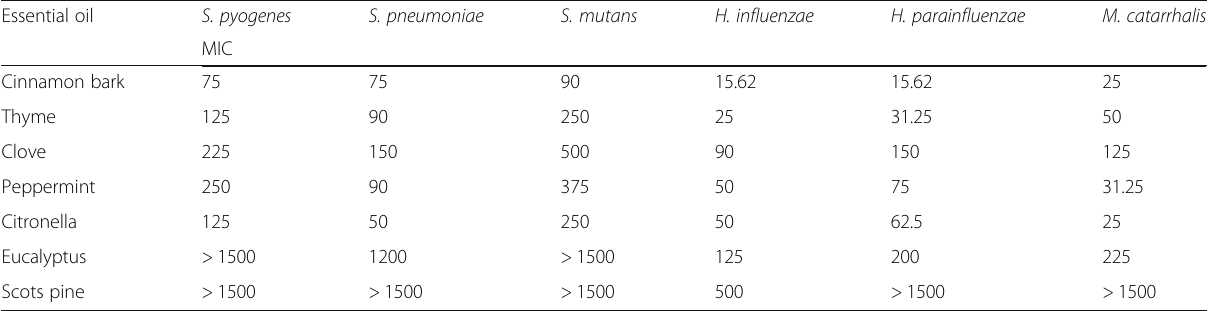
Table 5 Antibacterial activity of cinnamon bark, thyme, clove, peppermint, citronella, eucalyptus, and scots pine oils by vapor phase test Essential